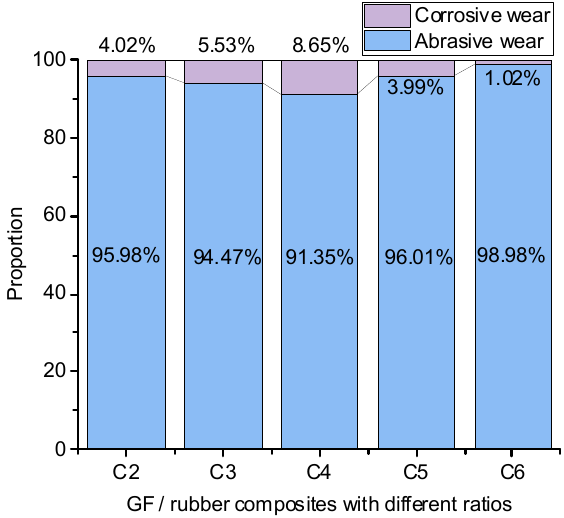
Figure 14. The proportion of abrasive wear and corrosion wear.